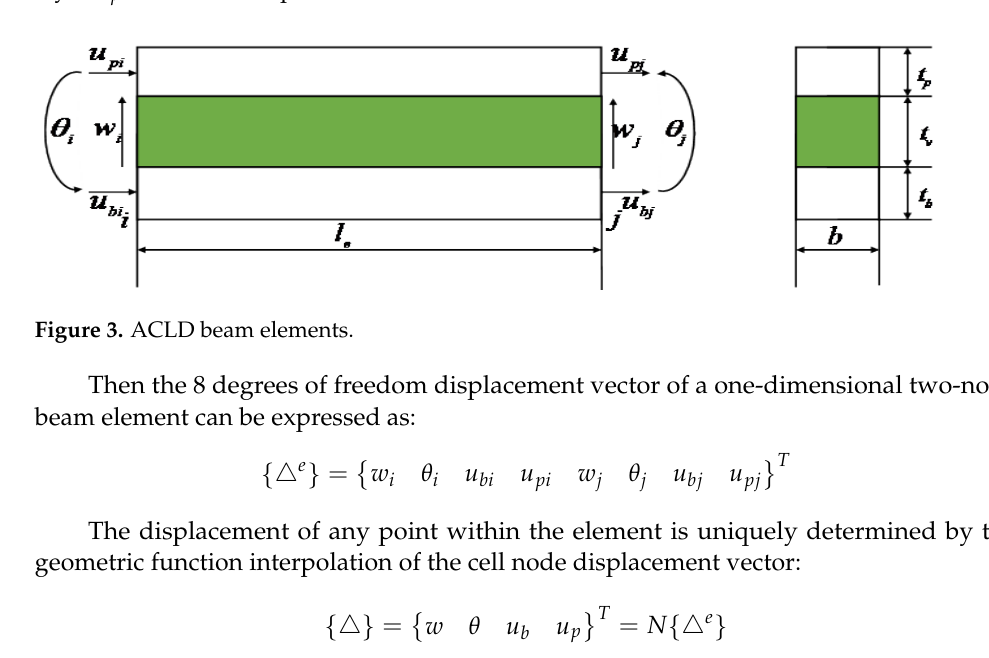
the longitudinal displacement of the base beam u b , the longitudinal displacement of the piezoelectric layer u p , the lateral displacement of the beam w and the corner of the beam element node θ .